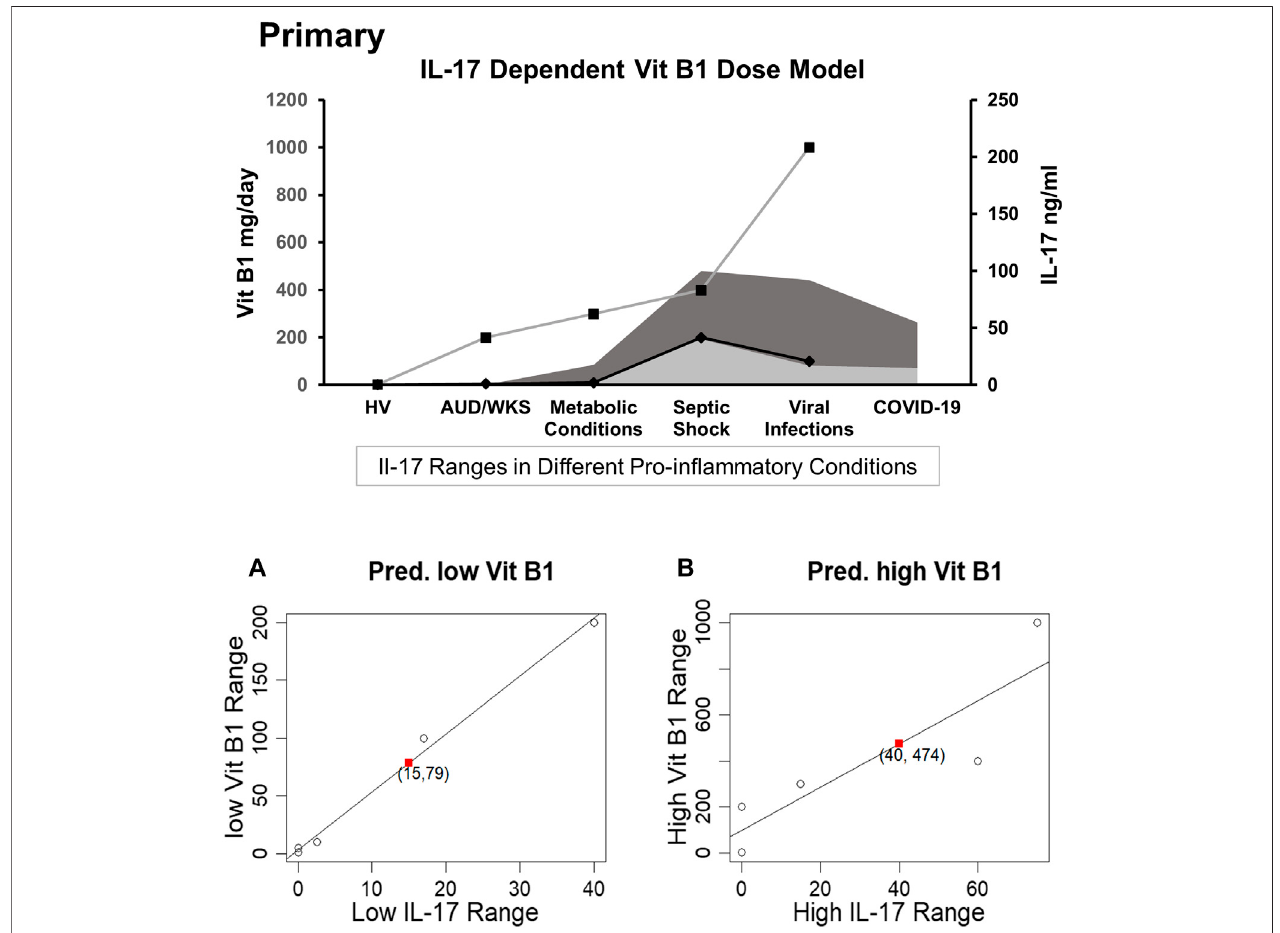
FIGURE2| PRIMARY:Adosetitrationbydiseaseandproin fl ammatoryTh17statusmodelofthiamineadministrationwithparallelrepresentationofTh17proin fl ammatory responsein various groups including healthy volunteersand diseasegroupswith pro-in fl ammatory response. (A) Linear regression modelis predictive for therelation between thelowdosethiamine(VitB1)rangevs.lowIL-17rangesbasedonknownobservedpairsfromdifferentpatients;lowerrangeofvitB1dose(79 mg/daily)correspondingtolower range of IL-17 (15 ng/ml) in the COVID-19 patients. Dark grey shade depicts higher IL-17 response and lighter grey shade shows lower IL-17 response in various proin fl ammatory conditions. (B) Linear regression showsthe predictive model forthe relation betweena higher range ofVit B1 dose vs. a higher range of IL-17 levels,derived from the known observed pairs from different patients; higher range of Vit B1 dose (474 mg/daily) corresponding to higher range of IL-17 (40 ng/ml) reported in COVID-19 patients. High Range Thiamine Dose: Left Y -axis (primary). Low Range Thiamine Dose, Low Range IL-17 levels, and High range IL-17 levels: Right Y -axis